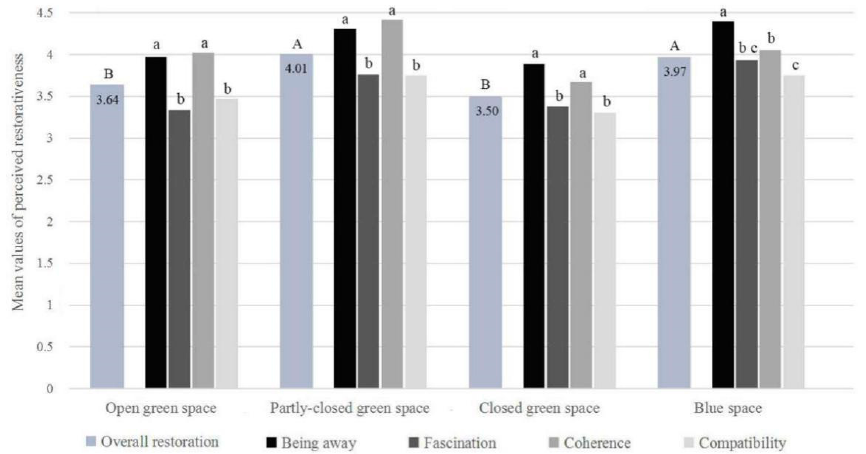
Figure 4. ANOVA with post hoc tests on differences in perceived restorativeness among the four study sites (Significant differences in overall restoration at the 0.05 level is shown by different letters A and B; significant differences in the four restorative components at the 0.05 level is shown by different letters a, b and c).